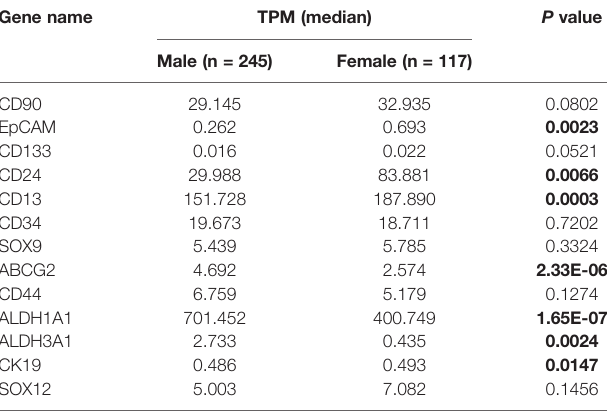
TABLE 2 | Expression of HCSC markers in HCC based on patient's gender in UALCAN database.